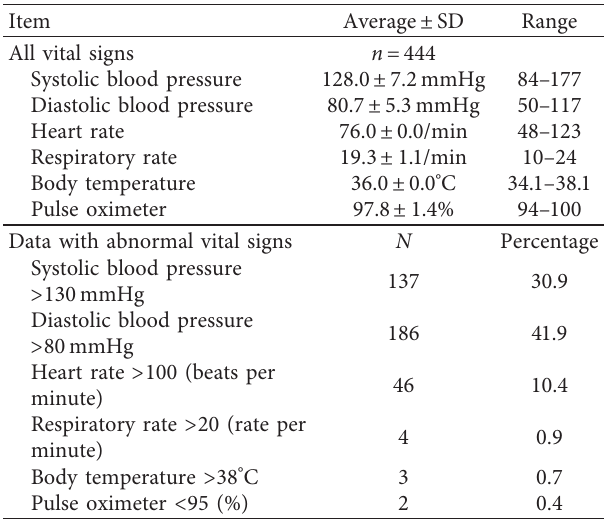
Table 3: Self-reported health assessment information for all DMAT members.